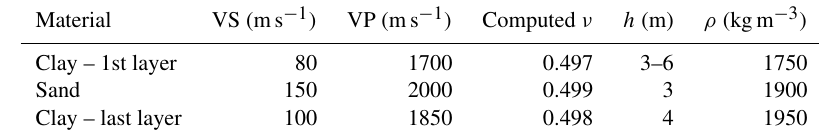
Table 2. Geophysical parameters of the sand bar model.